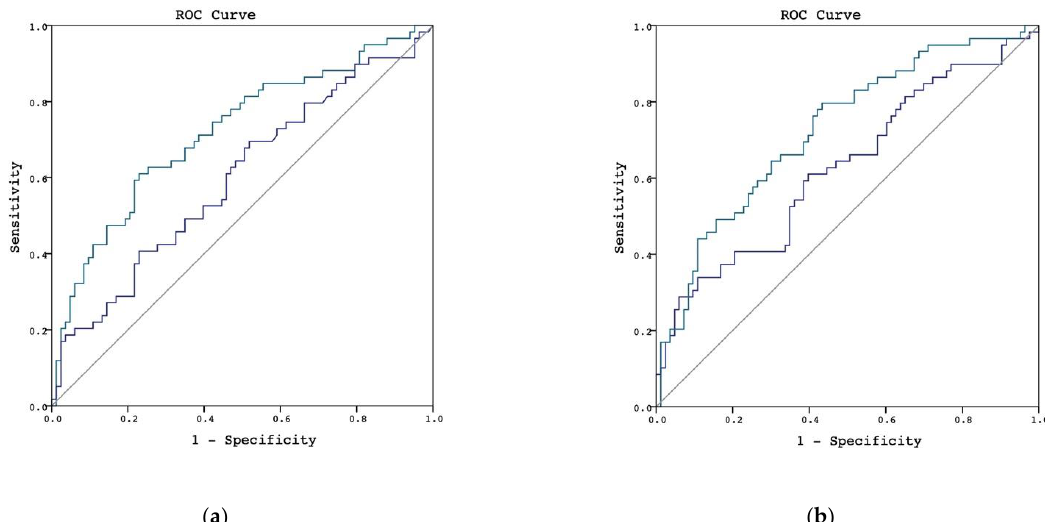
Figure 1. AUROC in discriminating postoperative AKI in whole patient population. ( a ) L-FABP in discriminating postoperative AKI, the urinary L-FABP at the first timepoint is shown by the blue line and the L-FABP at the second timepoint is shown by the green line. ( b ) L-FABP/creatinine ratio in discriminating postoperative AKI, the urinary L-FABP/creatinine ratio at the first timepoint is shown by the blue line and the L-FABP/creatinine ratio at the second timepoint is shown by the green line.